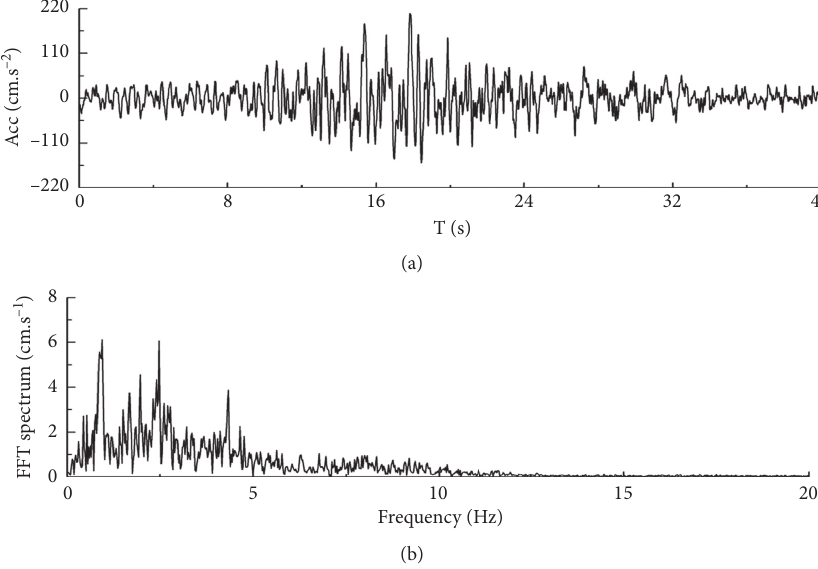
Figure 4: Horizontal acceleration history recorded at Tianshui seismostation during the Wenchuan earthquake.